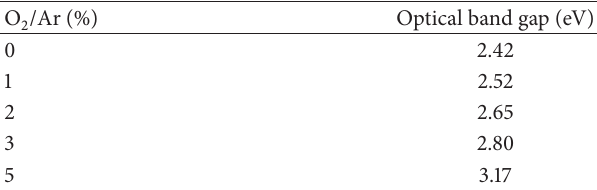
Table 1: The band gap of CdS:O films with O 2 /Ar ratio.